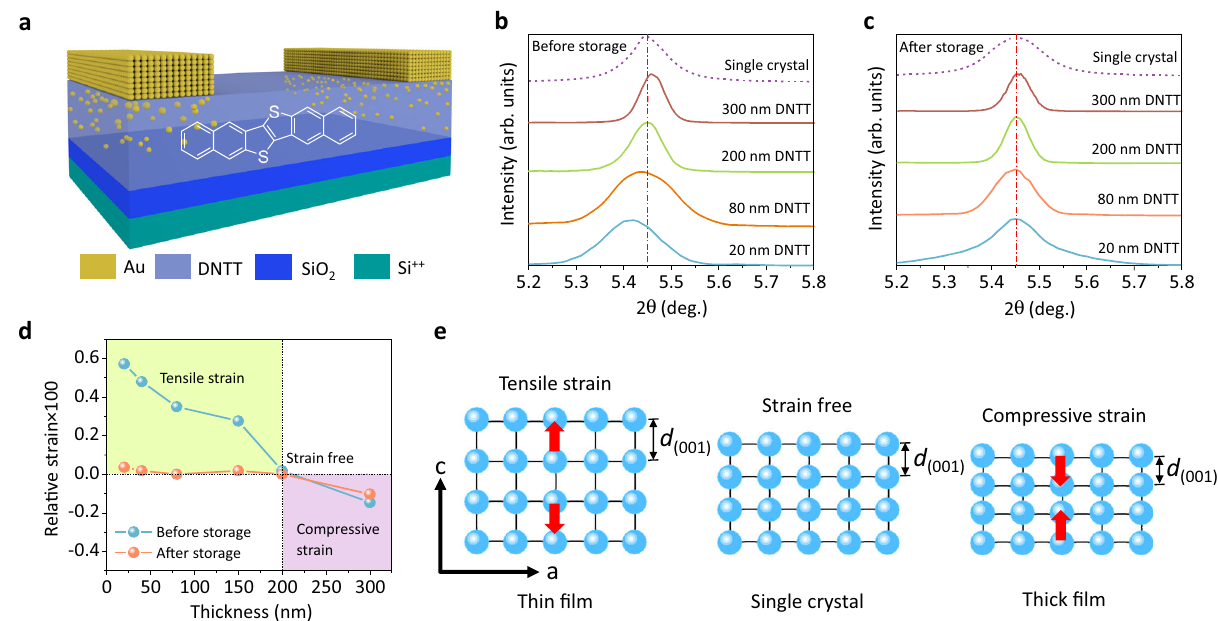
Fig. 1 Model OFETs with different fi lm thicknesses and strains. a Schematic diagram of the OFET with an optimal OSC fi lm thickness. The penetration of gold nanoclusters into the semiconductor layer is shown. XRD diffraction peaks of the (001) crystal plane of DNTT b before and c after fi ve years of storage. d Relative strain of DNTT fi lms with different thicknesses before and after storage. e Schematic diagram of the OSC lattice under tensile and compressive strain.